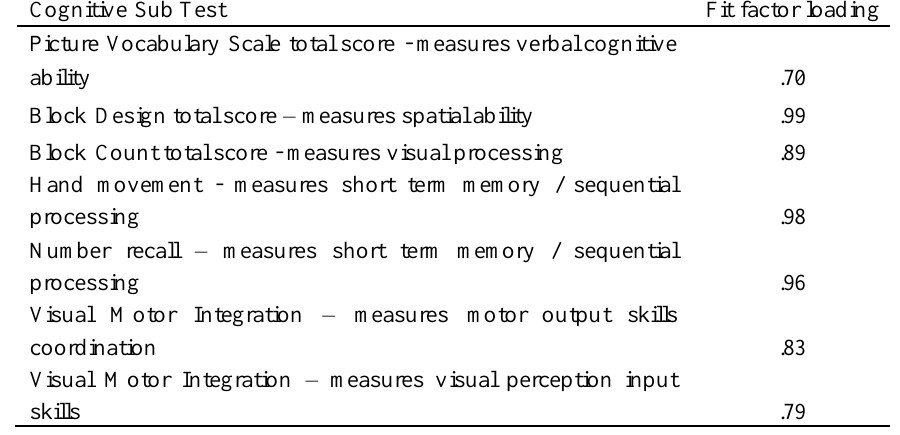
Confirmatory Factor Analysis of Cognitive Measures Cognitive Sub Test Fit factor